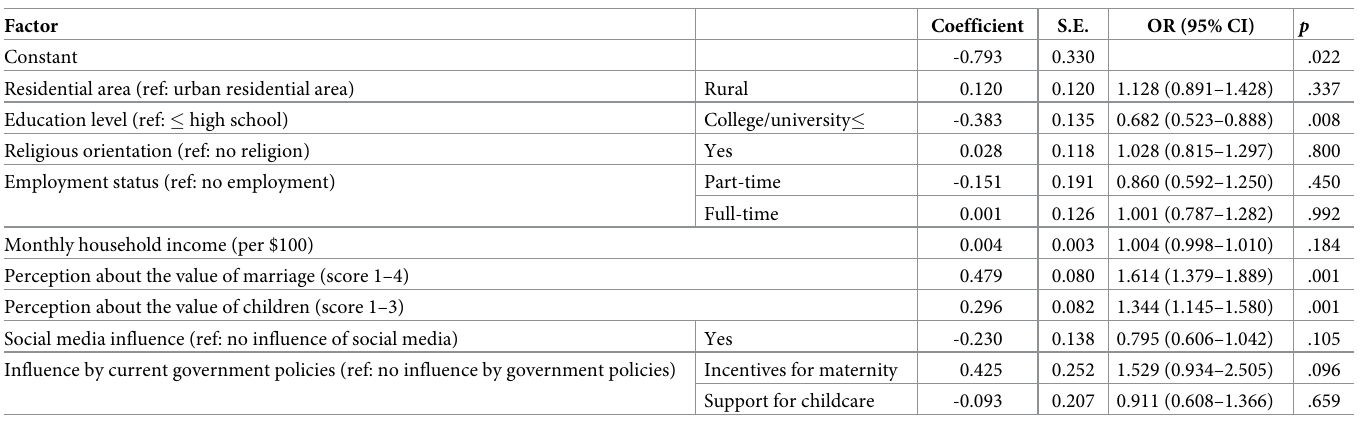
Table 2. Factors influencing women’s first childbirth (N =